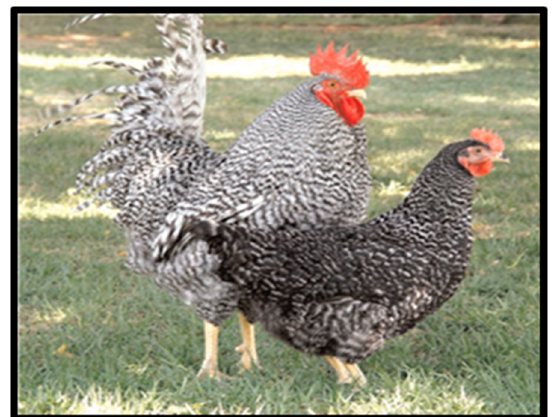
Figure 4. Potchefstroom Koekoek chicken breeds. Source: [51].